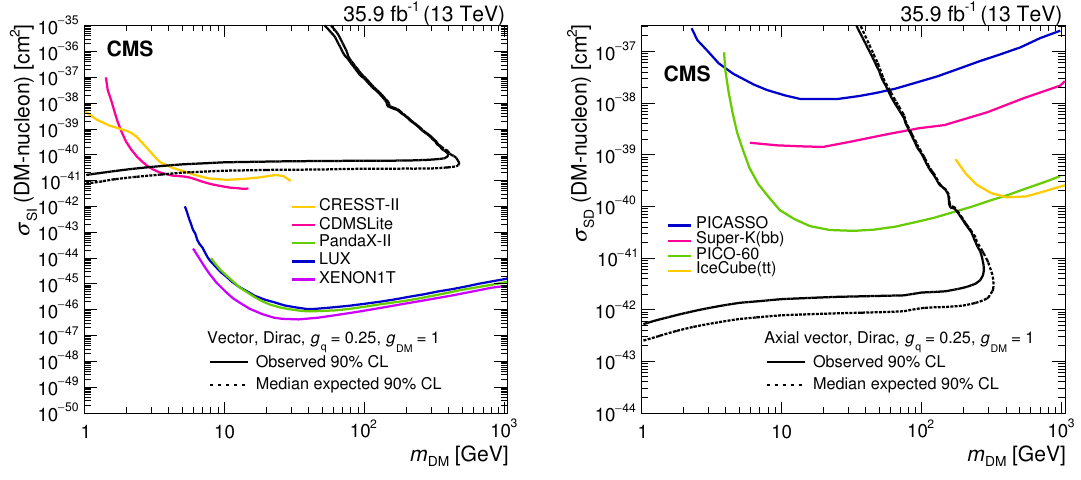
JHEP02(2019)074 = 0 : 25 and q = 1 g = 0.25, g Axial vector, Dirac, q DM Observed 90% CL = 0 : 25 and g = 1 are assumed. q DM